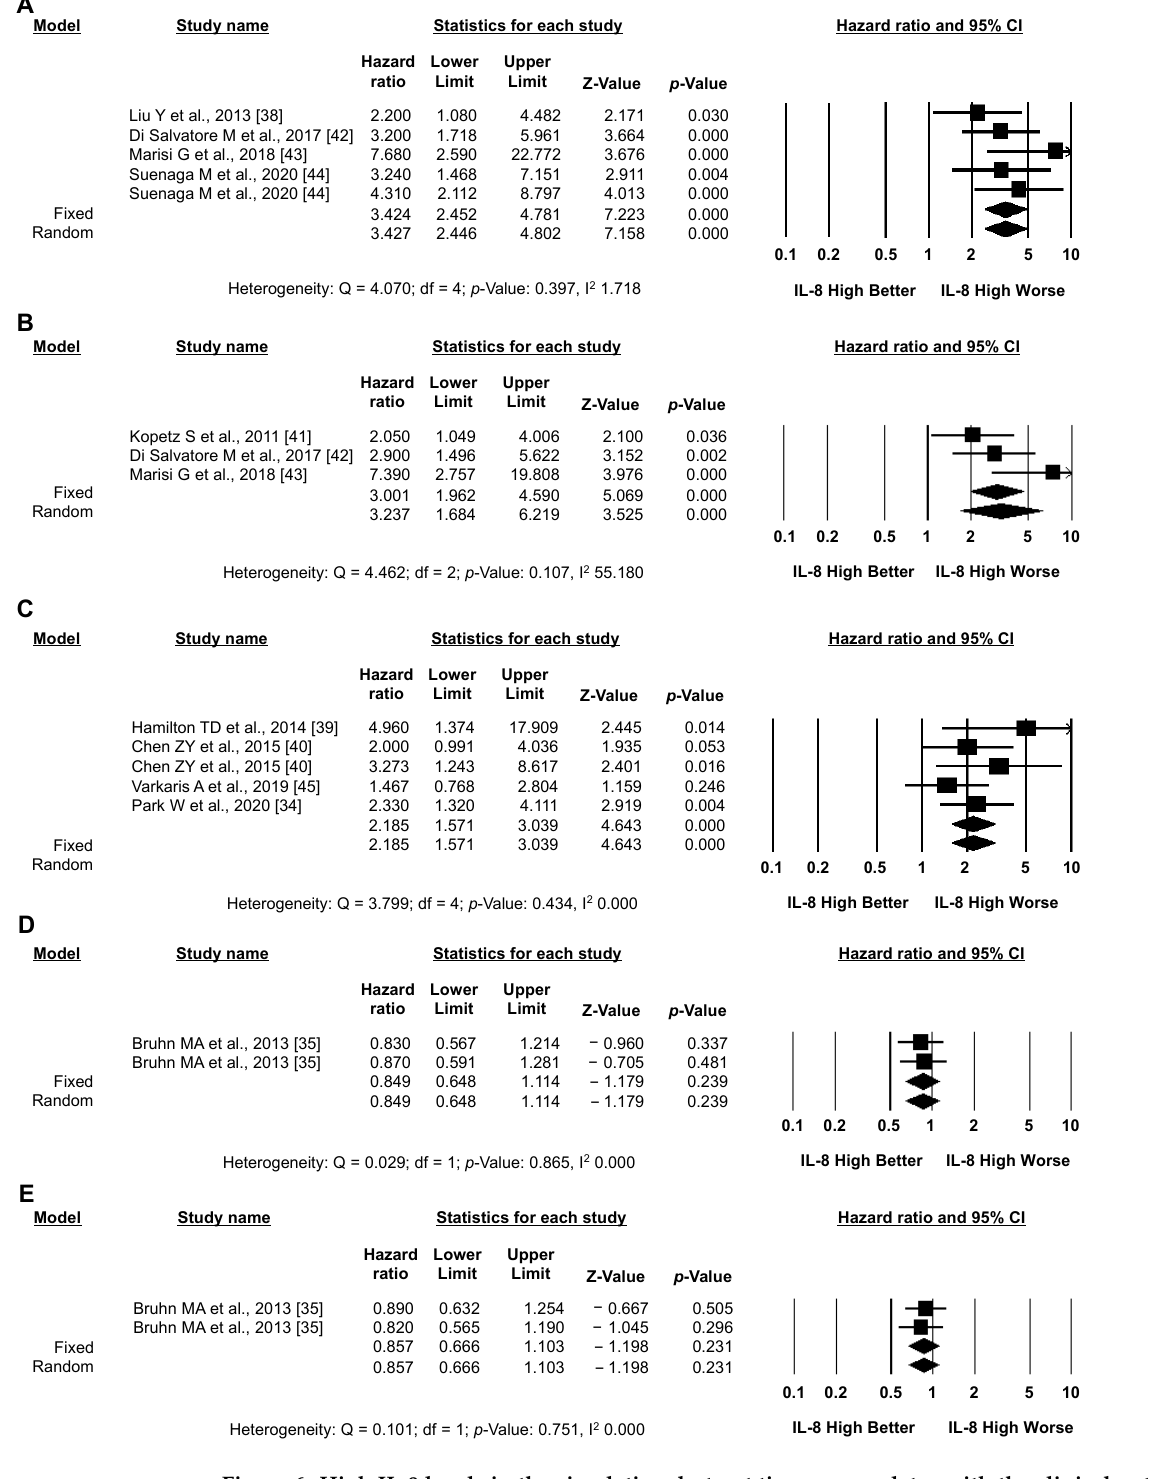
Figure 6. High IL-8 levels in the circulation, but not tissues, correlates with the clinical outcome of systemic treatment. Meta-analysis of the HR for the association of circulating IL-8 in relation to OS ( A , C ) or PFS ( B ) and patients who received anti-angiogenic agents ( A , B ) or chemotherapy without anti-angiogenic agents ( C ). Meta-analysis of the HR for the association of IL-8 found in tissues and OS ( D ) or PFS ( E )